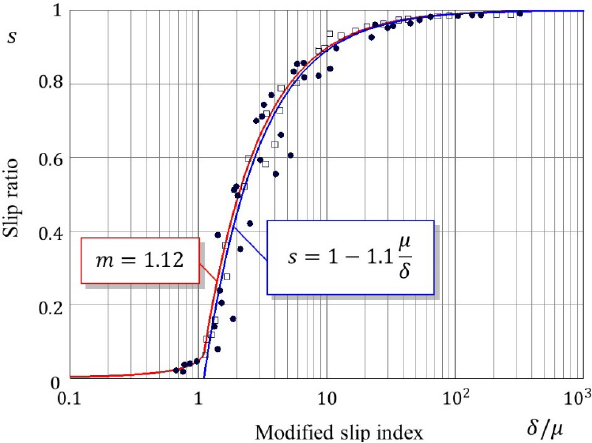
Fig. 6 Variation of the slip ratio s vs. the modified slip index /  . Experimental data is according to Refs. [11,